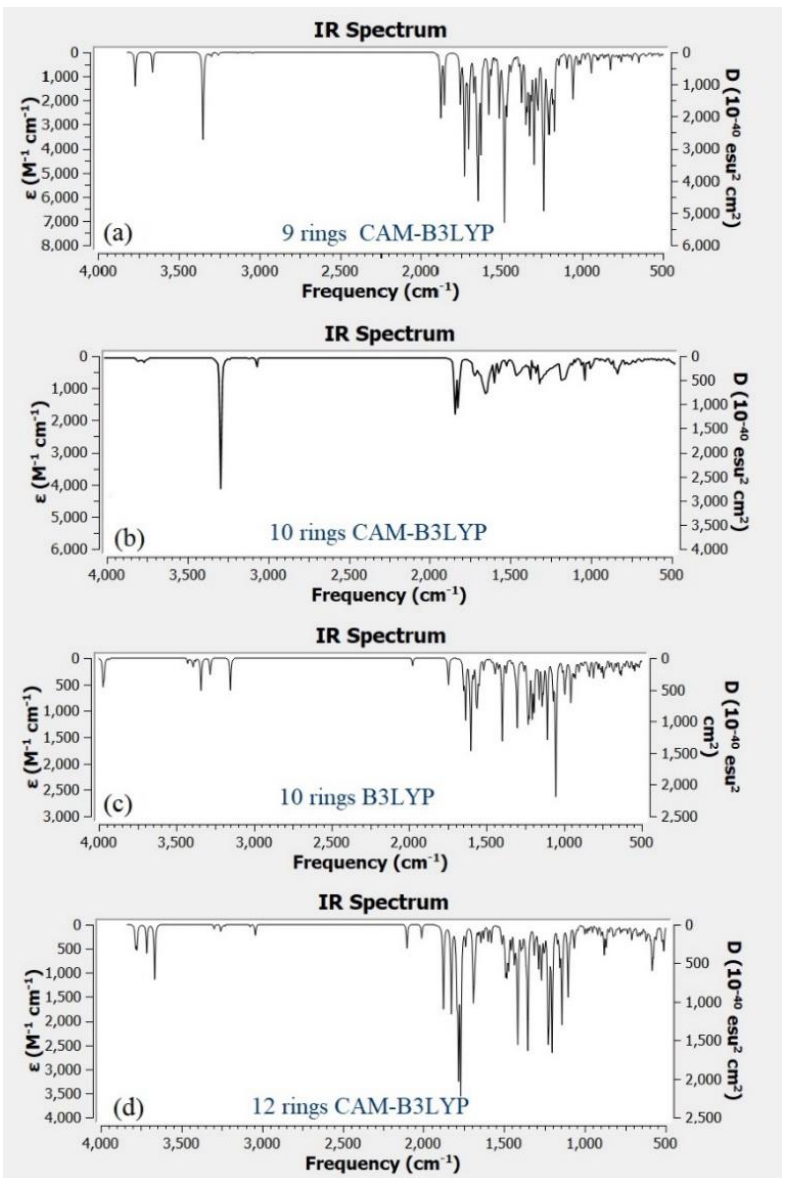
Figure 9. Infrared (IR) spectrum related to ( a ) CQD with 9 rings (CAM-B3LYP), ( b ) CQD with 10 rings (CAM-B3LYP), ( c ) CQD with 10 rings (B3LYP), ( d ) CQD with 12 rings (CAM-B3LYP). To continue the calculation, CAM-B3YLP method was used based on 6-31G (p) for a 10-ring molecule of CQD. The optimum structure at ground state was used for Natural Bond Orbital NBO analysis. The NBO analysis is significant to investigate the intra and inter molecular bonding, interaction among bonds, and charge distribution on the surface of CQD molecule. NBO provides molecular information such as population of Lewis and non-Lewis structure, the number of core (CR), two-centre bond (BD), three-centre bond (3C), long-pair NBO, non-Lewis (NL) with high occupancy, and Lewis (L) with low-occupancy orbital as shown in Table 5. In order to obtain the acceptable Lewis structure, the occupancy of orbitals should exceed the occupancy